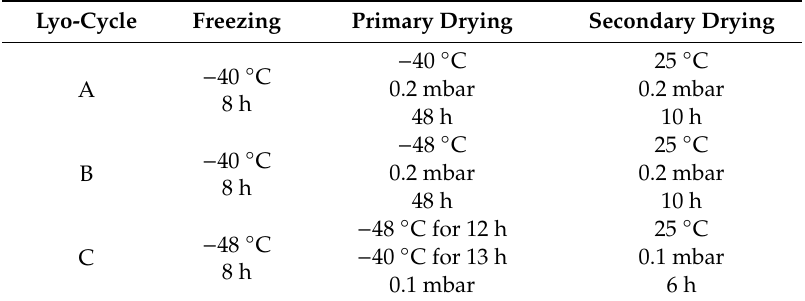
Table 1. Schematization of process parameters of